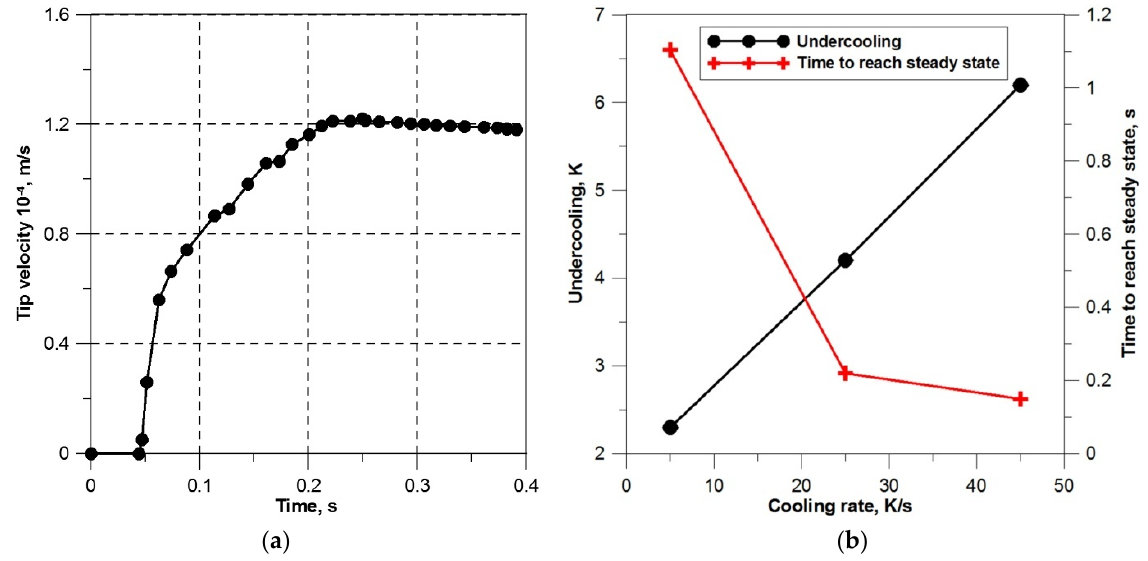
Figure 5. Kinetic characteristics of the initial solidification period: ( a ) the growth rate of the dendrite front, ( b ) the effect of the cooling rate on the concentration undercooling value and the transition time from the transient state to the steady state.